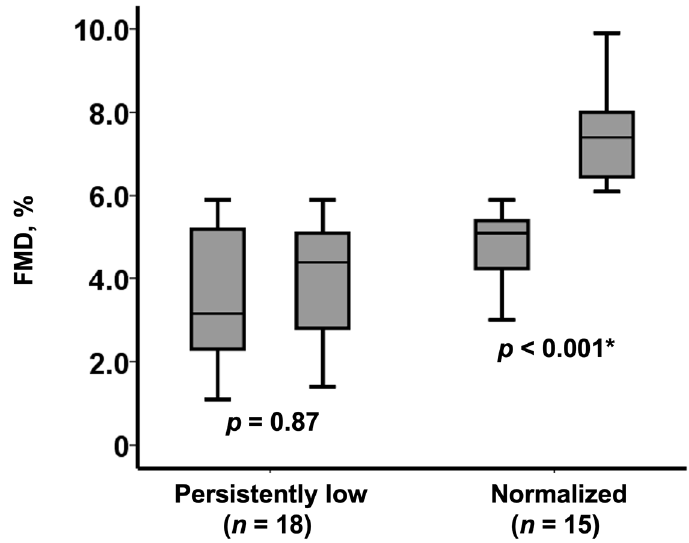
Figure 2. Change in FMD following TAVI among those with baseline low FMD ( n = 33). FMD remained persistently low in 18 patients whereas normalized in 15 patients. * p < 0.0.5 by Wilcoxon signed-rank test.